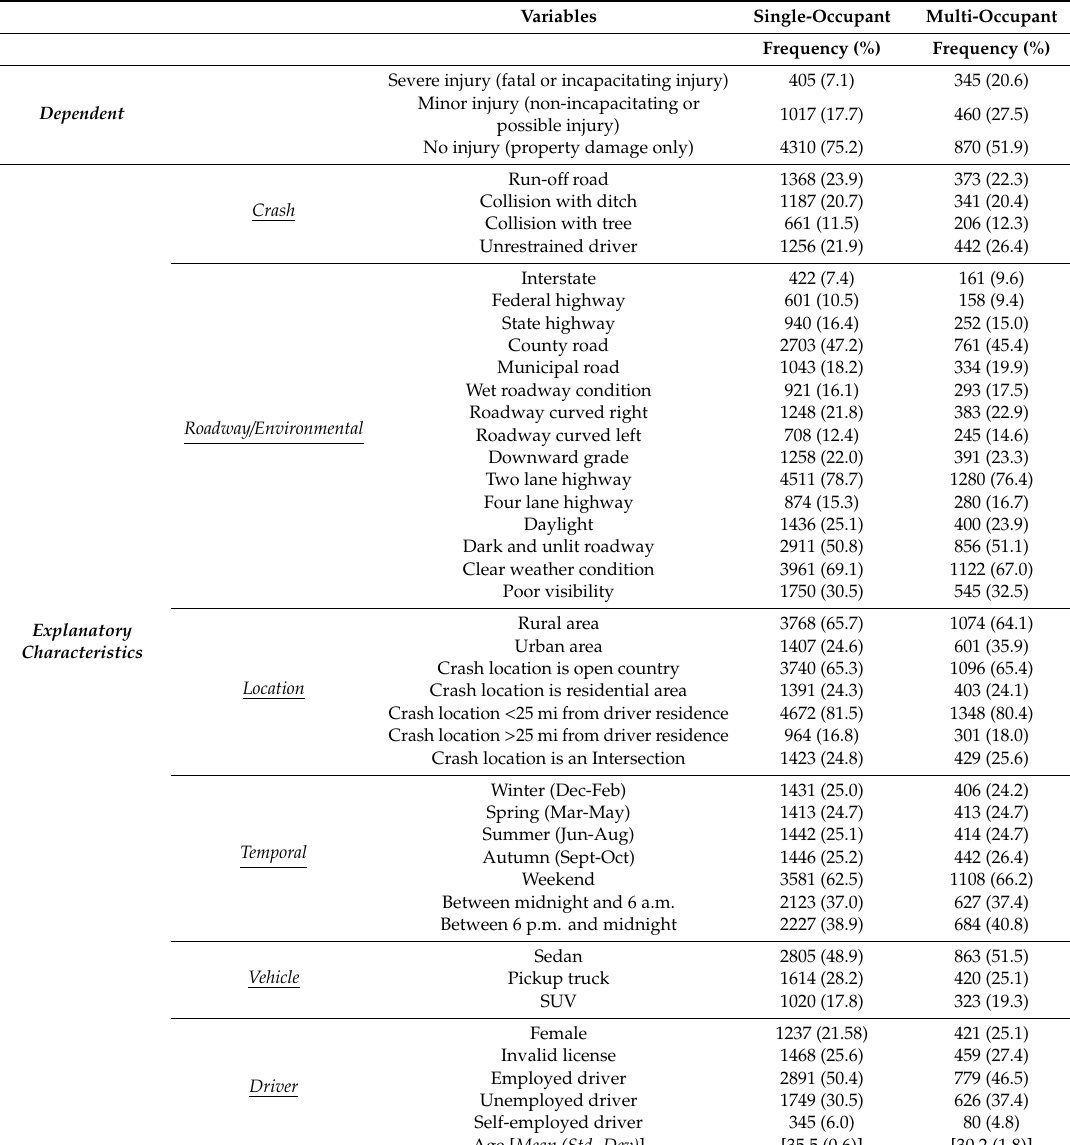
Table 1. Summary statistics of variables included in the latent class logit